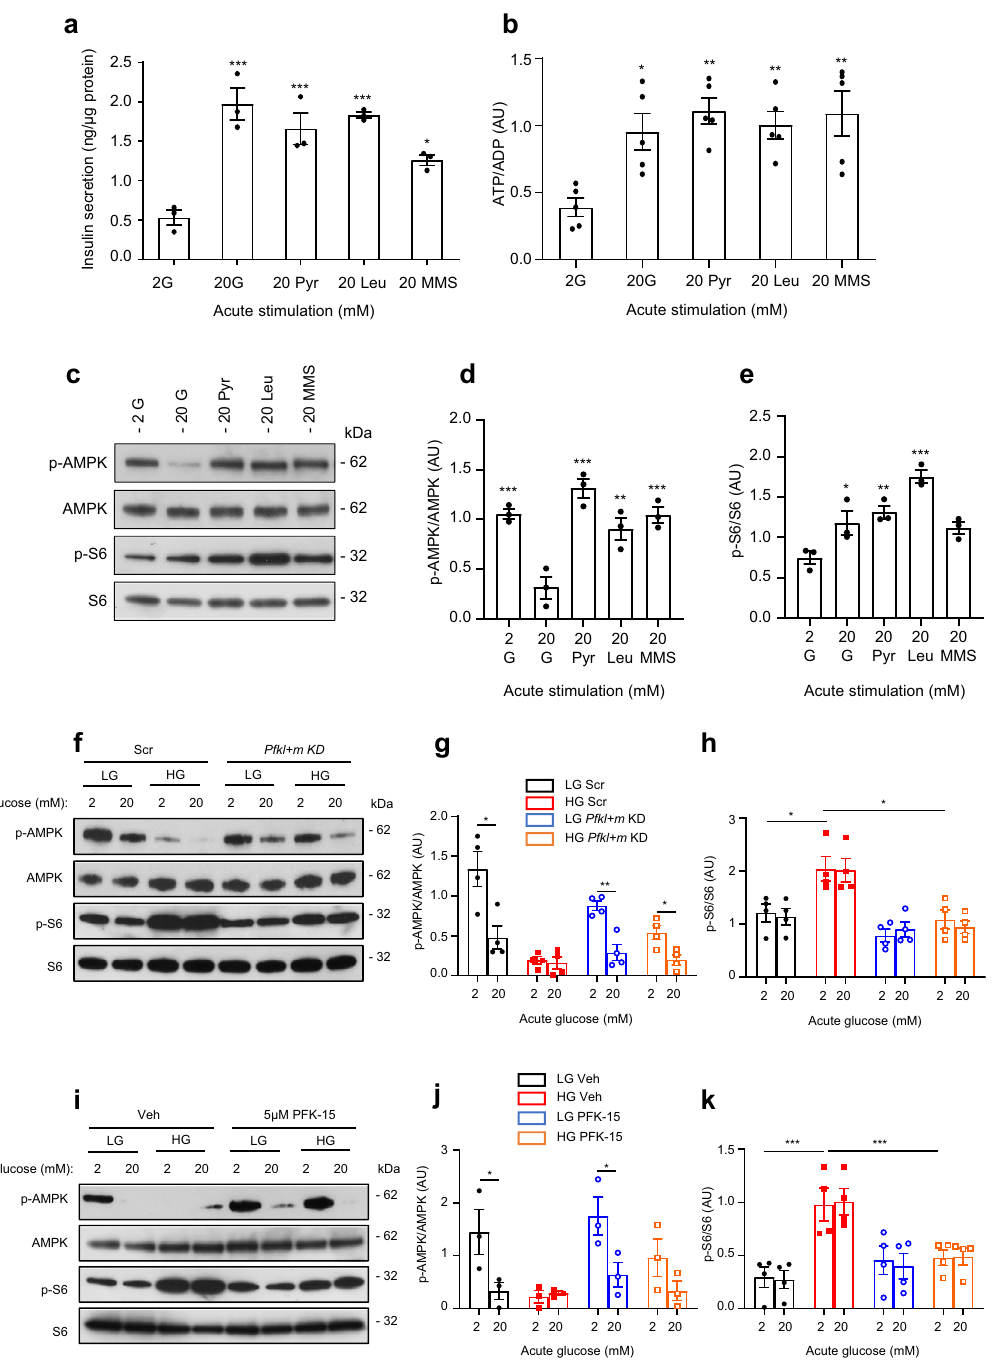
Fig. 6 | Mitochondrial substrates elevate ATP and insulin secretion but do not suppress AMPK signalling. a , b Insulin secretion ( a , n =3 biologically indepen- dent experiments) and ATP/ADP ratio ( b , n =5 biologically independent experi- ments) in LG-cells stimulated with 20mM glucose (G), methyl pyruvate (Pyr), leucine (Leu) or monomethylsuccinate (MMS) for 1h. c Representative Western blot of lysates from LG-cells acutely exposed to 2mM glucose or 20mM of the indicated mitochondrial substrates for 1h. Uncropped blots in source data. d , e Quantitativedensitometryanalysisofp-AMPK/AMPK( d )andp-S6/S6( e )inLG- cells stimulated with 20mM glucose (G), methyl pyruvate (Pyr), leucine (leu) or monomethysuccinate (MMS) for 1h ( n =3 biologically independent experiments). f Representative Western blot of lysates from cells transfected with scrambled siRNA (Scr) or Pfkl and Pfkm siRNA ( Pfkl+m KD) and cultured at low (LG) or high (HG) glucose for 48h. Cells were subsequently stimulated with 2mM or 20mM glucose for 1h. Phosphorylated (p) and total AMPK and S6. Uncropped blots in